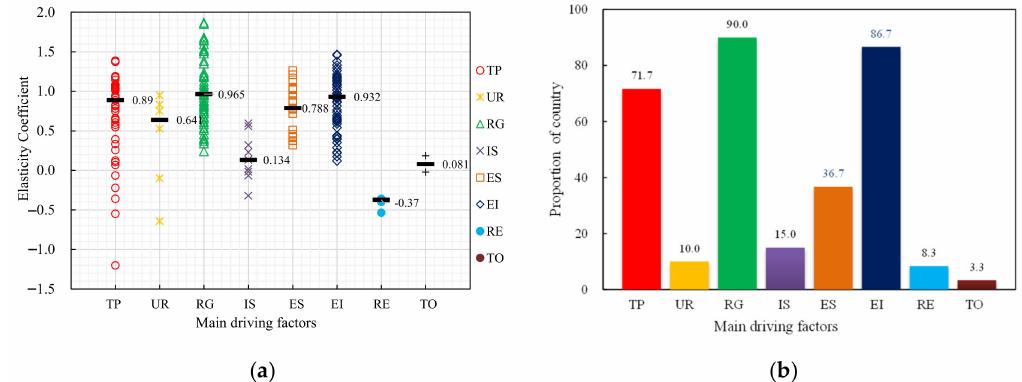
Figure 1. The elasticity coefficients of MDFs and its proportion: ( a ) The elasticity coefficients of MDFs; ( b ) The proportion of countries having the factor as one of their